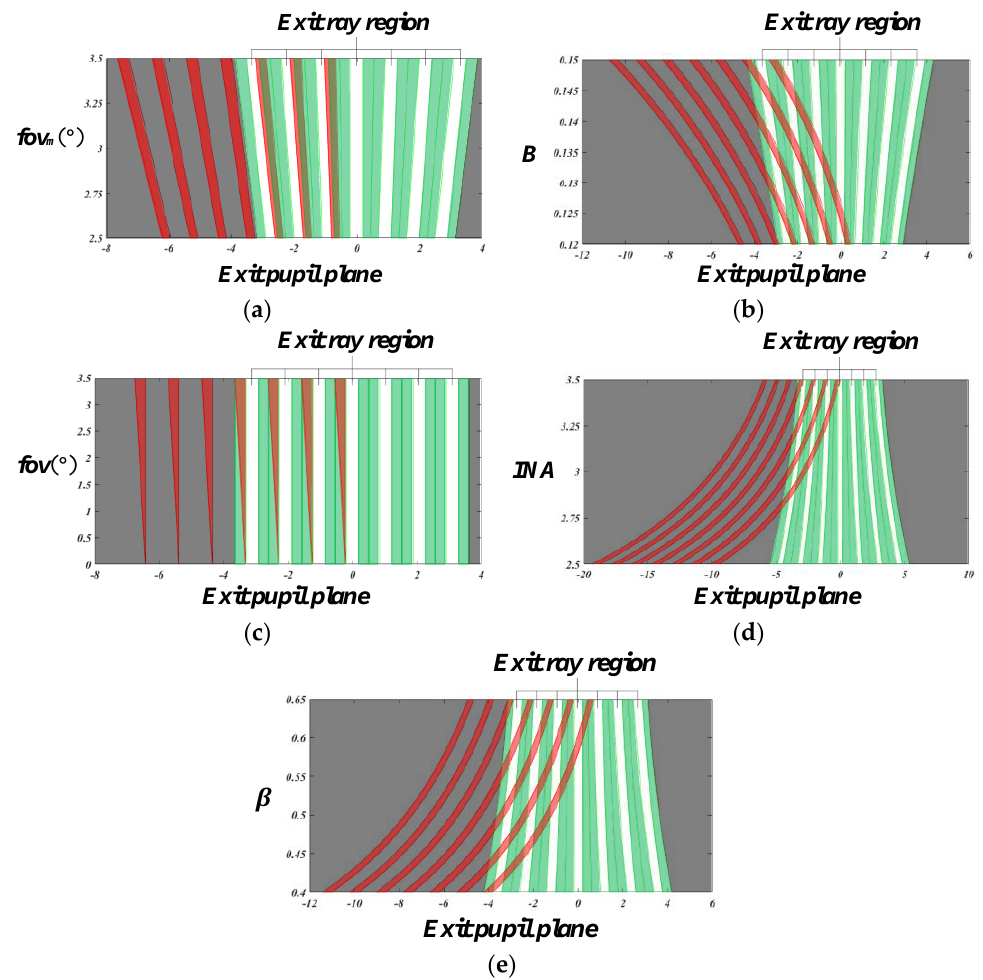
Figure 11. Different plots on the exit pupil plane. ( a ) Plot between fov m and the exit pupil plane (where fov = fov m , B = 0.1333, n L = 4.025, INA = 3.3438°, β = 0.5333, t d = 3.0). ( b ) Plot between B and the exit pupil plane (where fov m = 3°, n L = 4.025, INA = 3.3438°, β = 0.5333, t d = 3.0). ( c ) Plot between fov and the exit pupil plane (where fovm = 3°, B = 0.13333, n L = 4.025, INA = 3.3438°, β = 0.5333, t d = 3.0). ( d ) Plot between INA and the exit pupil plane (where fov m = 3°, B = 0.13333, n L = 4.025, β =0.5333, t d = 3.0). ( e ) Plot between β and the exit pupil plane (where fovm = 3°, B =0.13333, n L = 4.025, INA = 3.3438°, t d = 3.0).